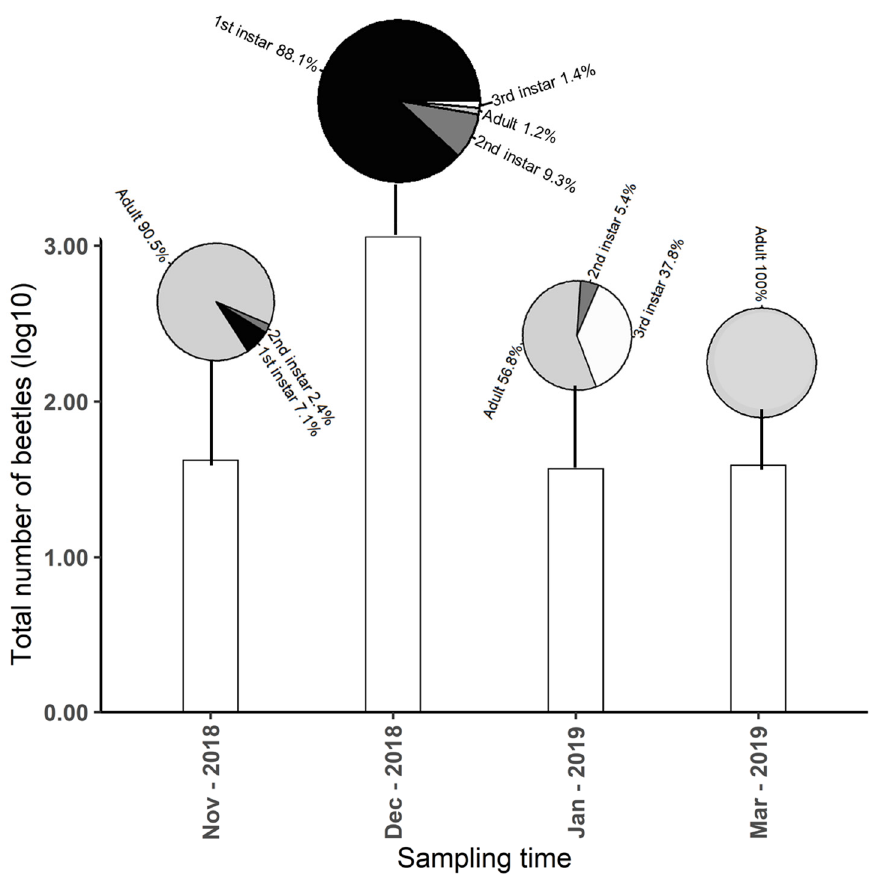
Figure 3. Developmental stage and abundance of Lochmaea suturalis during the four volatile organic compound (VOC) measurements periods. Bars indicate the total number of L. suturalis present and pie charts show the proportion of each developmental stage at a given sampling time.